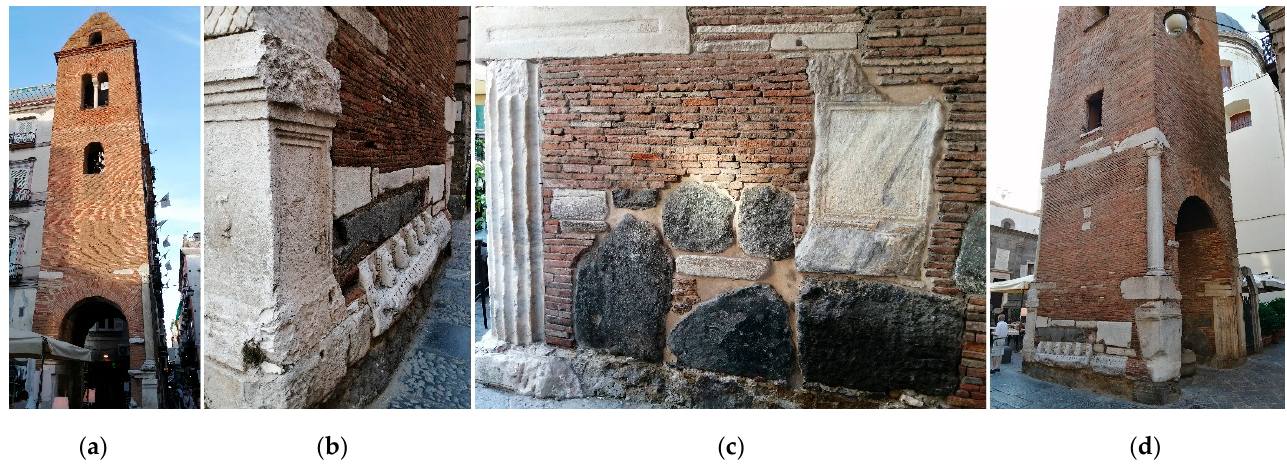
Figure 2. Bell tower of “Santa Maria Maggiore della Pietrasanta” (pictures of G.B.): ( a ) Bell tower front view; ( b ) Detail of the base facing the street; ( c ) Detail of the base; ( d ) Bell tower back view.